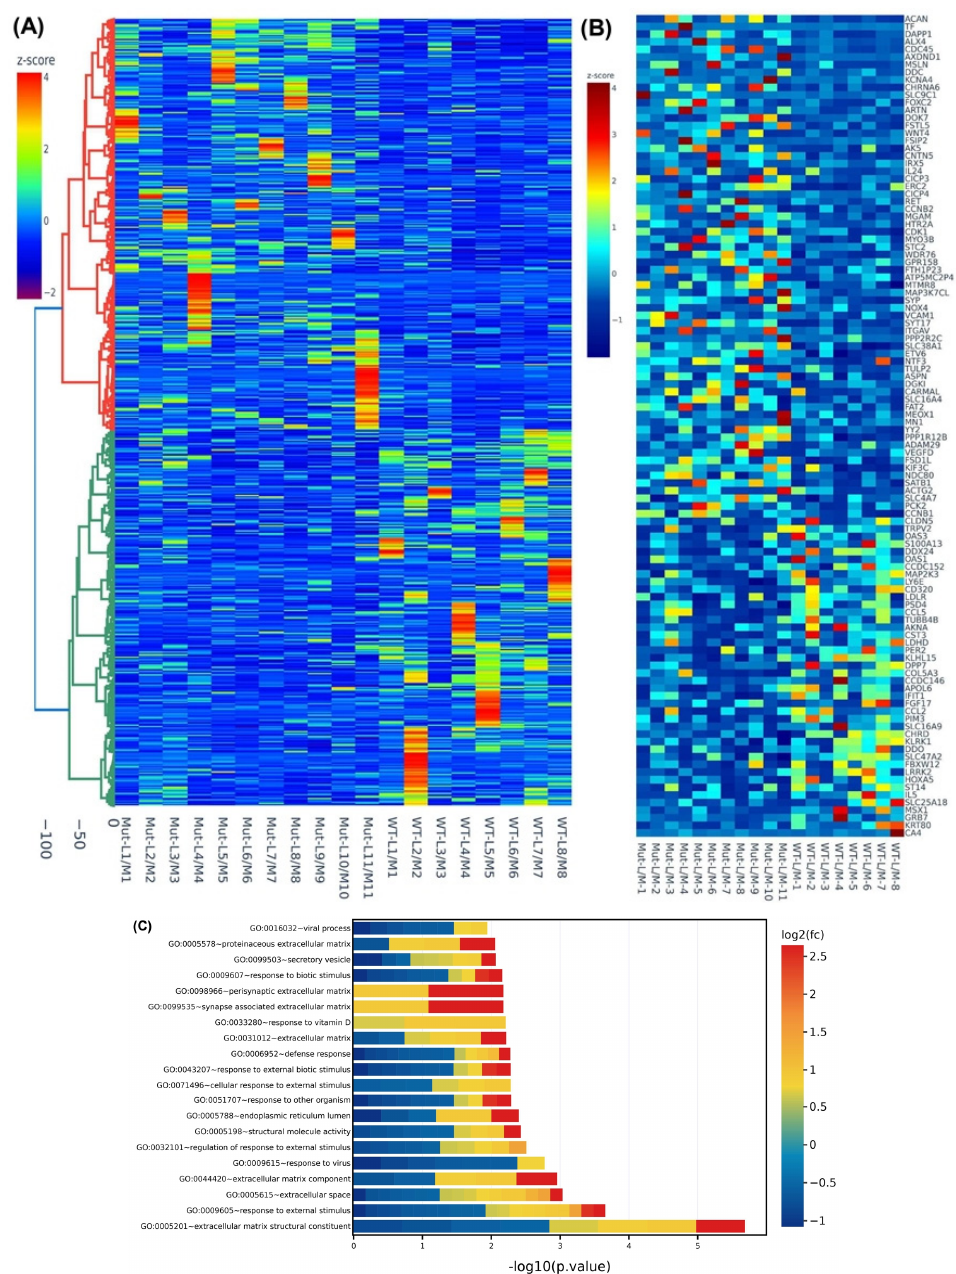
Figure 2. Differential levels of transcriptomic heterogeneity of genes in paired specimens analyzed based on MED12-mutation status. ( A ) Hierarchically clustered heatmap analysis was performed as fold change (leiomyoma/paired myometrium) comparing the MED12-mutated (n = 11) with the non-mutated (n = 8) group (fold change ≥ 1.5, p < 0.05). Color gradient represents gene expression as z-scores. ( B ) Heatmap of the 109 enriched genes (leiomyoma/paired myometrium) in the MED12-mutated (n = 11) but not in the non-mutated (n = 8) group (fold change ≥ 1.5, p < 0.05). Color gradient represents gene expression levels as z-scores. ( C ) Gene ontology (GO) analysis of 394 differentially expressed genes (leiomyoma/paired myometrium) in the MED12-mutated (n = 11) but not in the non-mutated (n = 8) group (fold change ≥ 1.5, p < 0.05). Color gradient represents levels of log2 fold change presented as